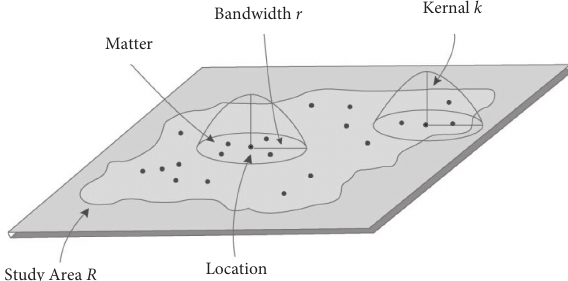
Figure 1: The demonstration of KDA